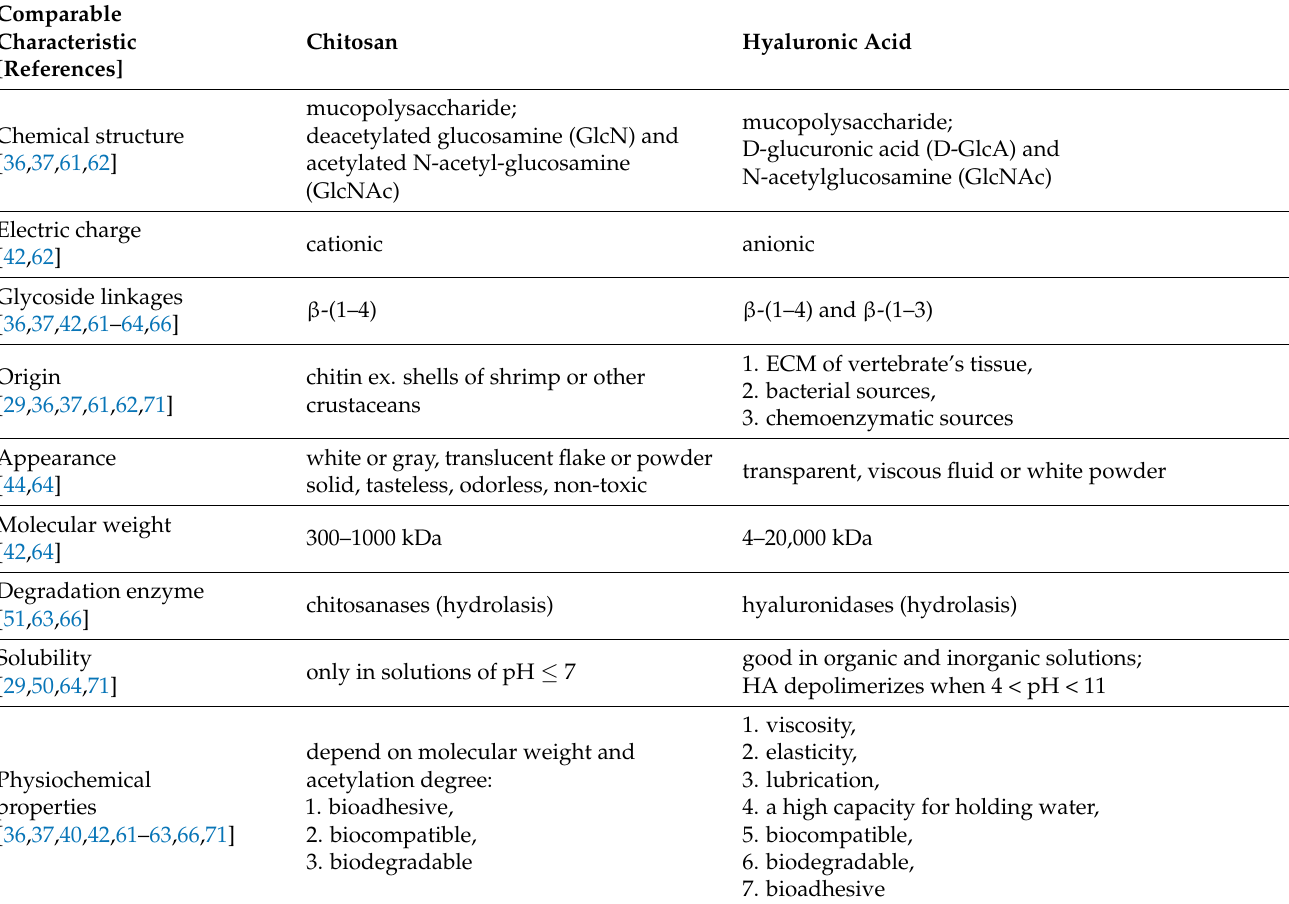
Table 2. Comparison of the physical and biochemical properties of chitosan and HA based on the